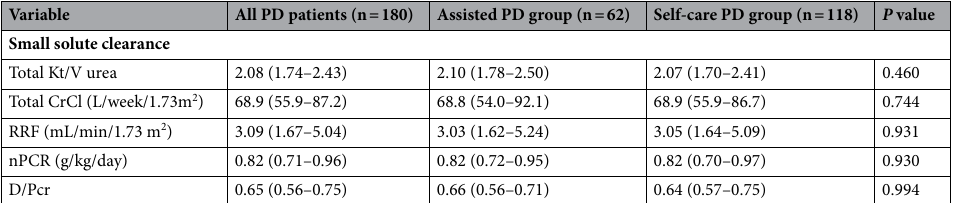
Table 2. Small solute clearance and peritoneal transport characteristics. Values expressed as mean ± standard deviation, median (25th–75th percentile), or absolute numbers with percentages [n (%)]. Abbreviations: